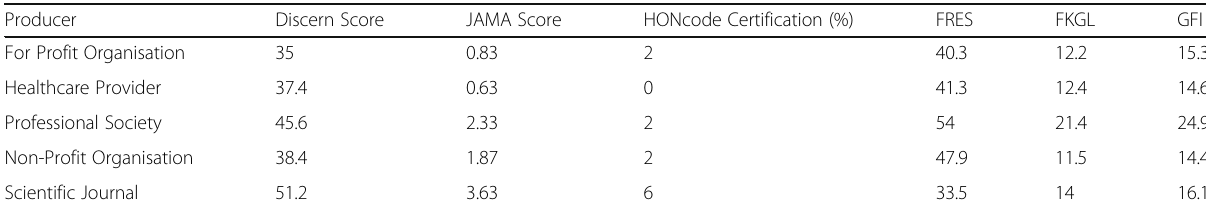
Table 4 Summary of